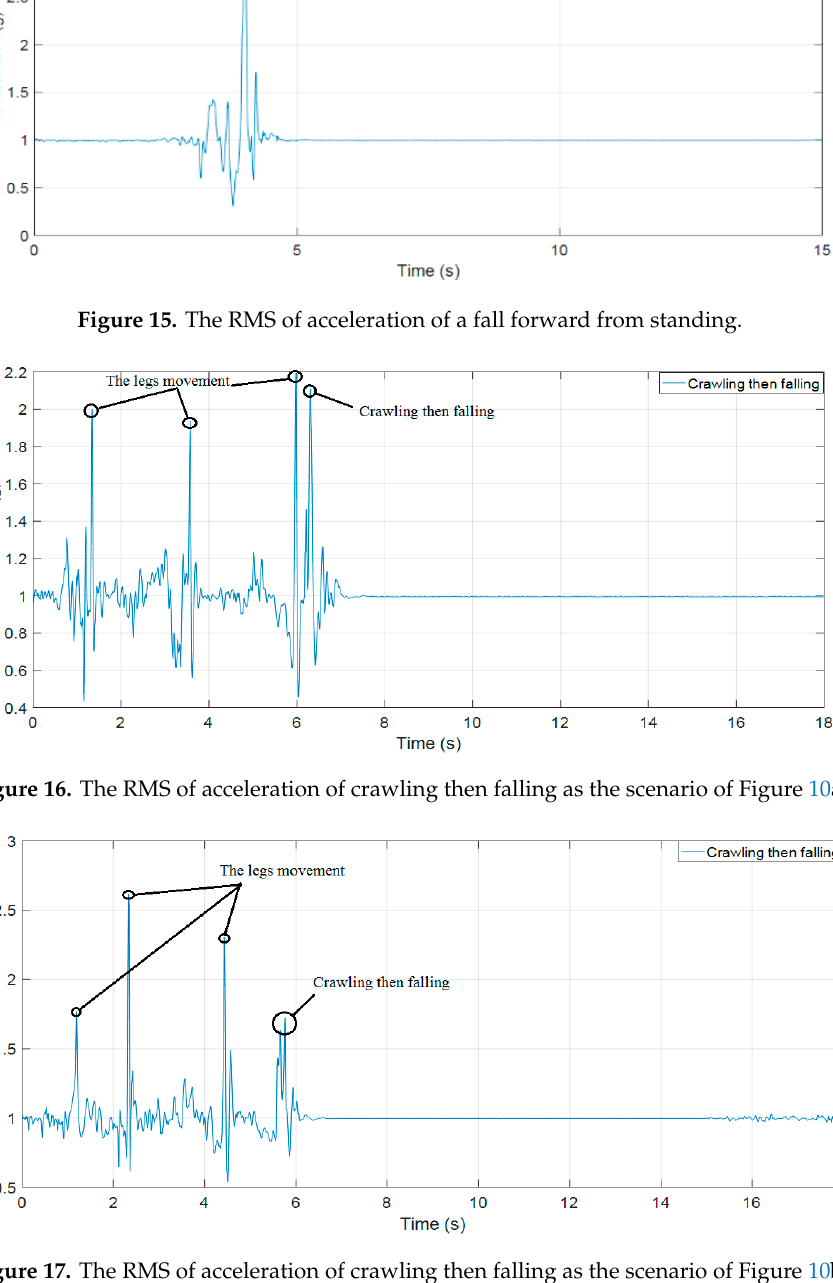
Figure 17. The RMS of acceleration of crawling then falling as the scenario of Figure 10b.